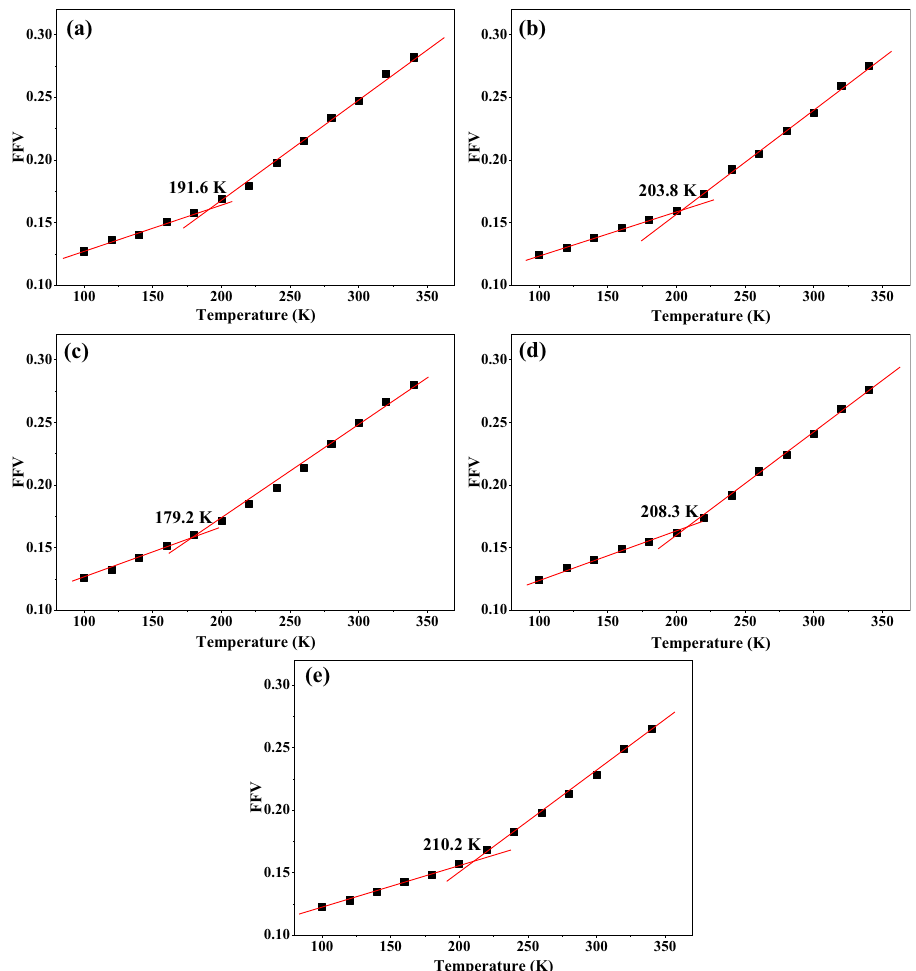
Fig. 10 Estimated T g of the typical aged PDMS models via density vs. temperature results. a M3, b M4, c M7, d M10, and e